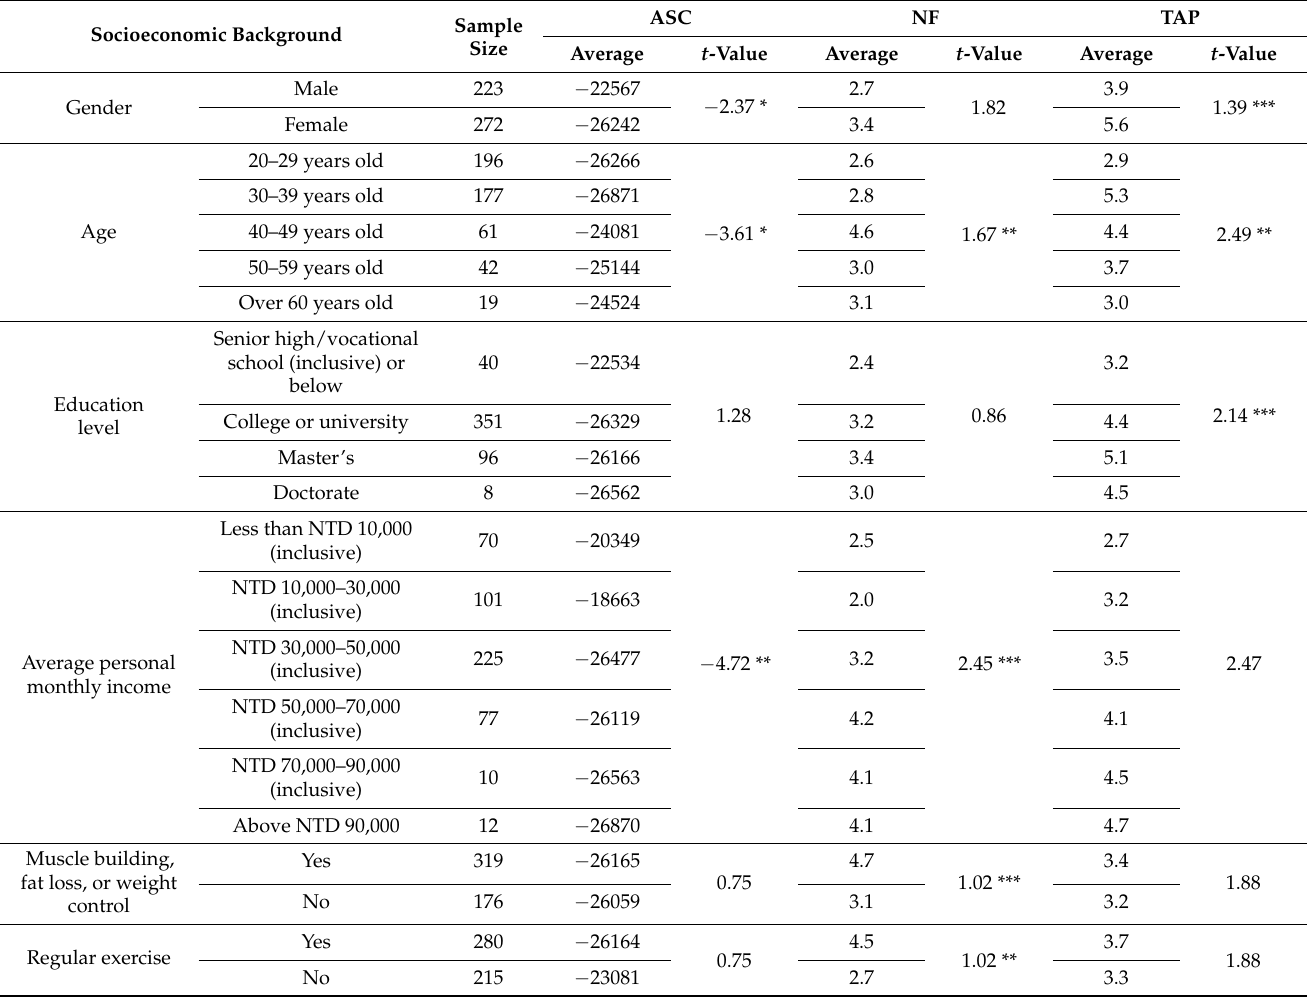
Table 4. Comparison of respondents’ socioeconomic background and WTP for the attributes of healthy boxed